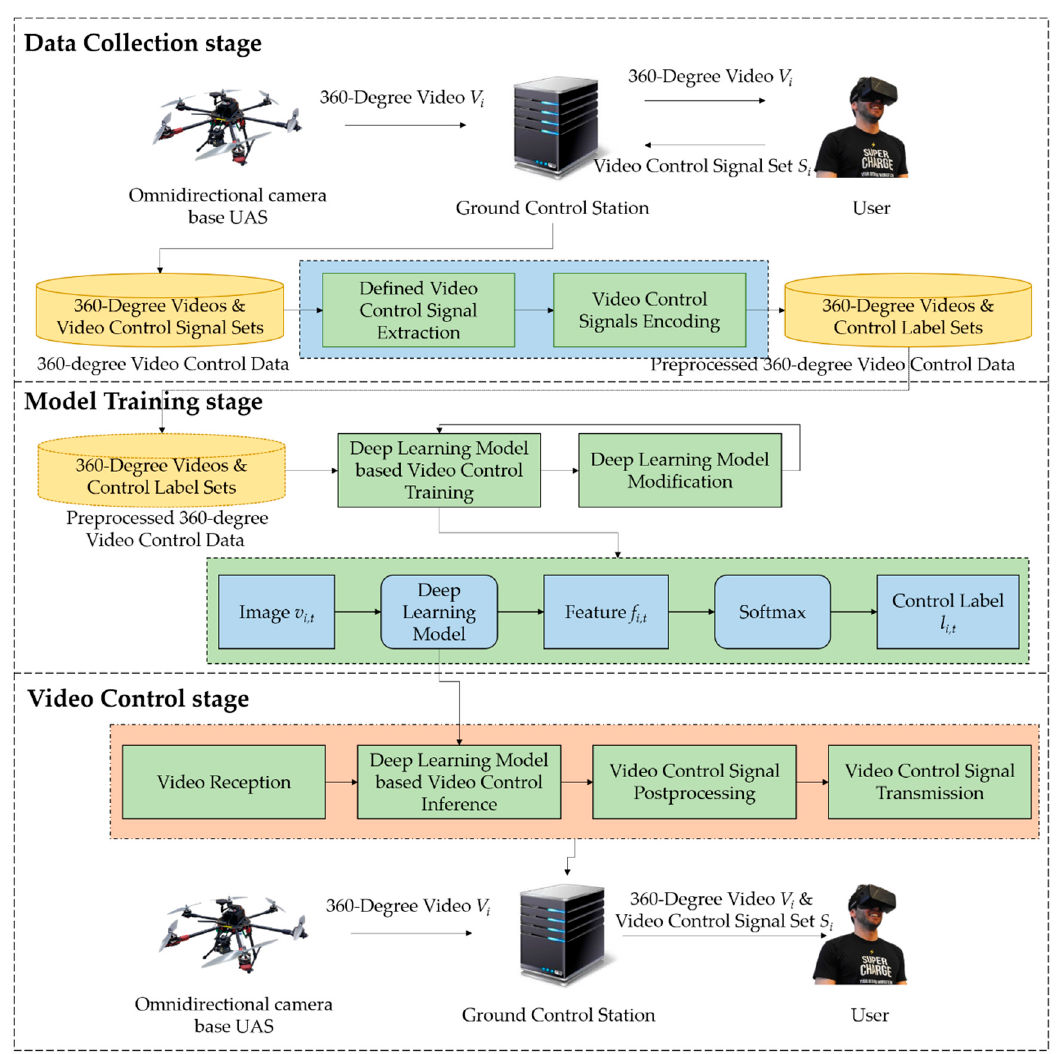
Figure 1. In the process of micro unmanned aircraft systems (micro UAS) autonomous flight, a 360-degree video captured by an omnidirectional camera is used to provide a normal field of view (NFoV) to the user.